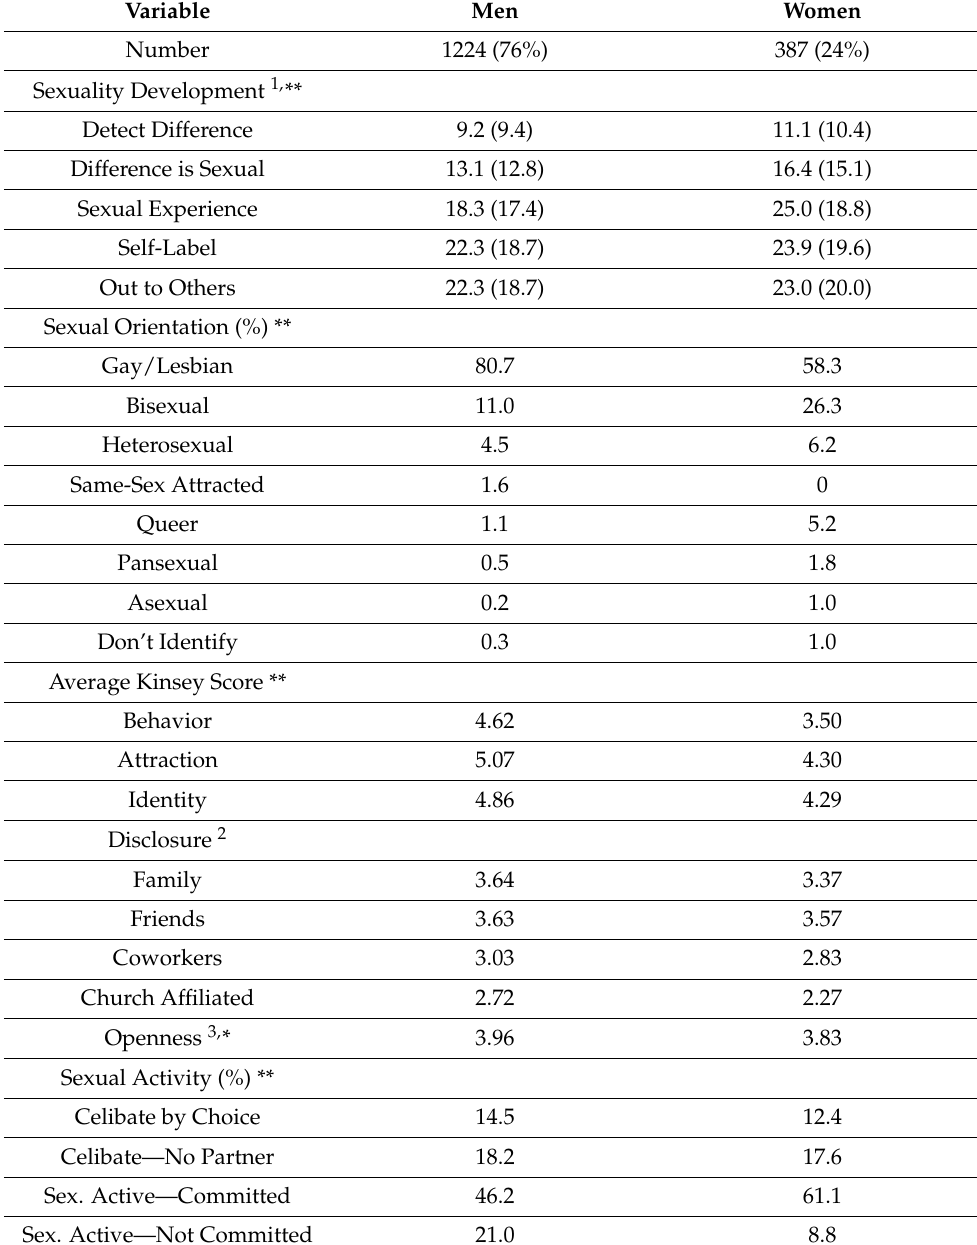
Table 1. Sexuality Measures in the LGBTQ LDS